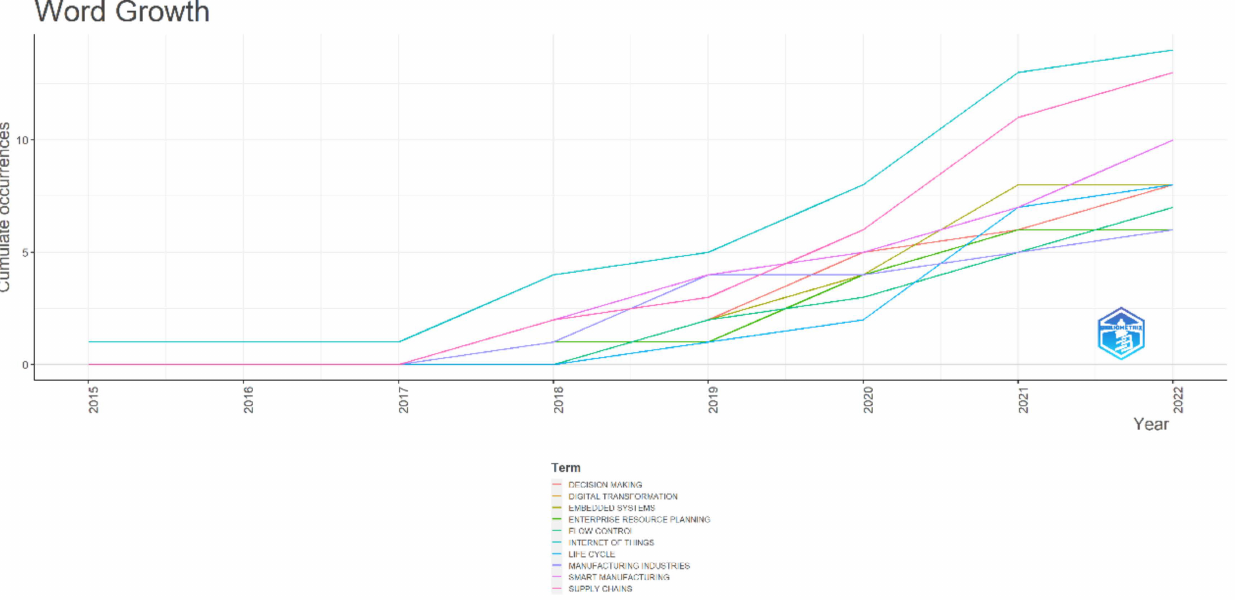
Figure 2. Work Growth (Keyword